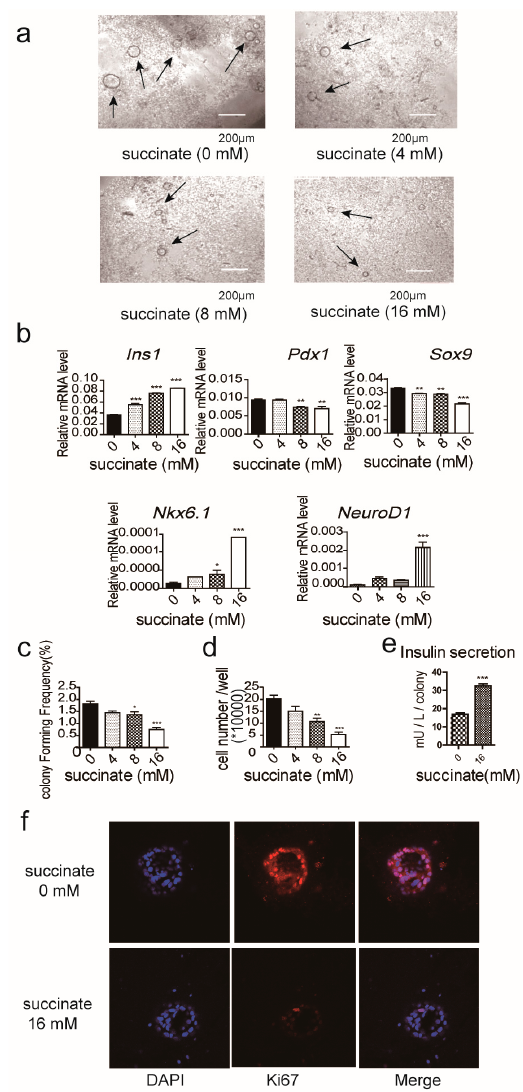
Figure 4. The effect of succinate on the proliferation of pancreatic progenitor-like cells in 3D culture. ( a ) The digested pancreatic single cells were cultured with the addition of 0 mM, 4 mM, 8 mM or 16 mM succinate for 14 days; the colonies were observed under an inverted microscope; nuclei were stained with DAPI; ( b ) the expressions of progenitor- and differentiation-related genes were analyzed by Real-time PCR; ( c ) tThe colony forming frequency was calculated as described; ( d ) the cell numbers/wells from colonies were counted by utilizing a cell counter; ( e ) the insulin secretion of colonies was detected by an insulin detection ELISA kit, in accordance with the manufacturer’s instructions; ( f ) the Ki67 levels in the 3D culture with 0 mM and 16 mM succinate were detected by immunofluorescence under a laser scanning confocal microscopy; nuclei were stained with DAPI. The arrows are used to point colonies for easy viewing and identification. Results are shown as means + SEM and represent three independent experiments. *** p < 0.001 versus 0 mM succinate group; ** p < 0.01 versus 0 mM succinate group; * p < 0.05 versus 0 mM succinate group.